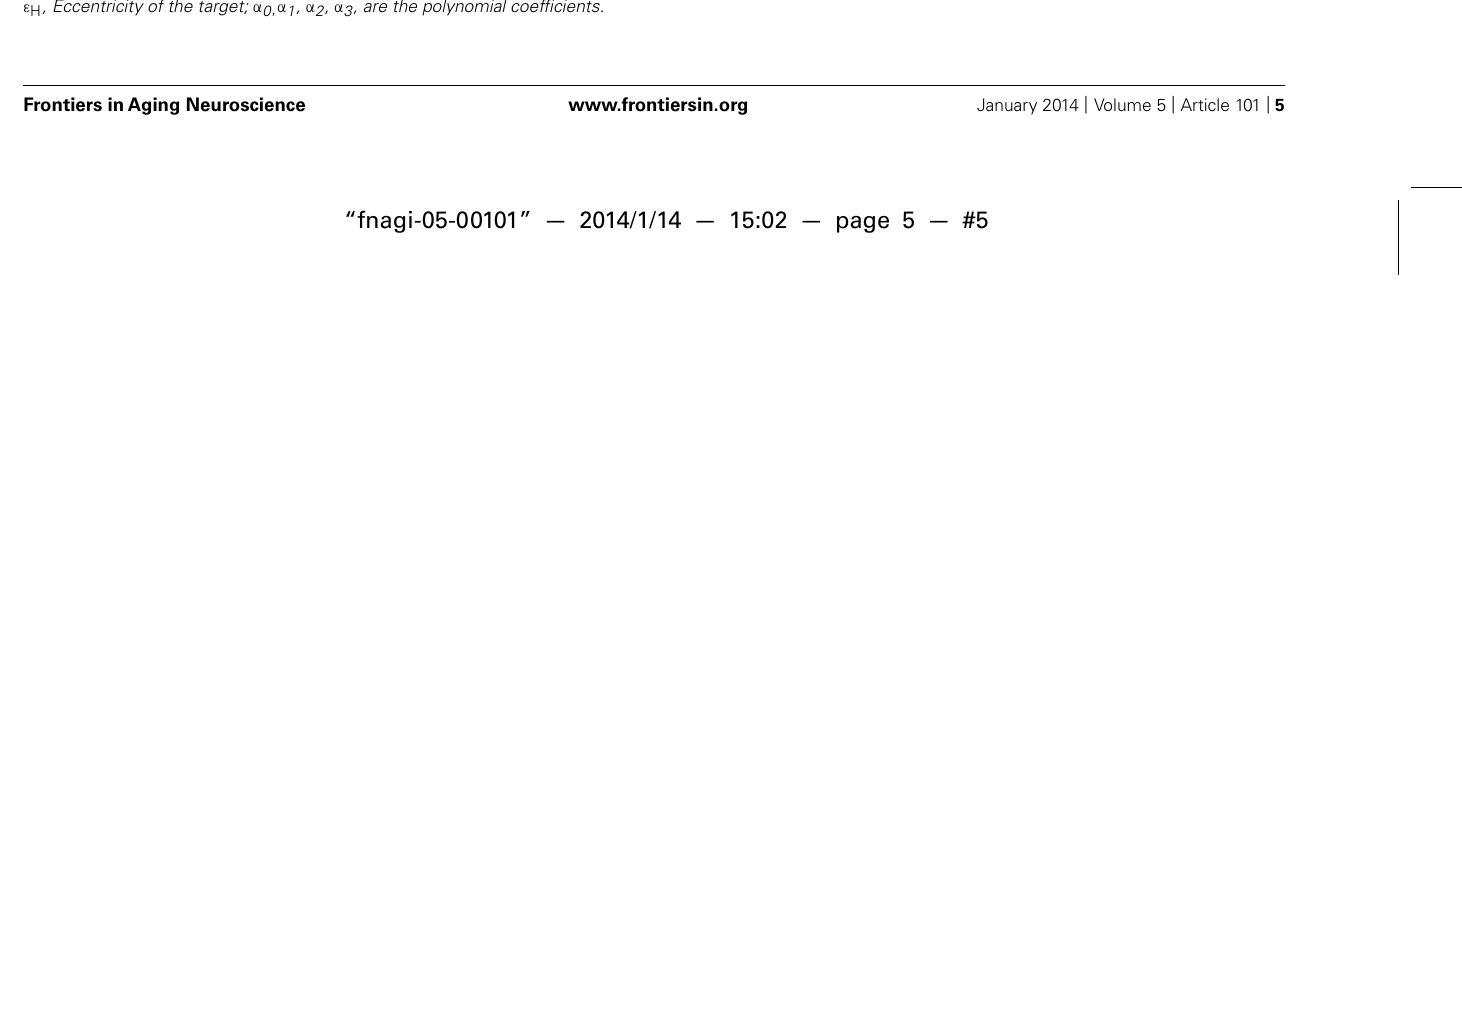
Table 2 |Values of the polynomial regression analysis for the target detection performance and the reaction time. α